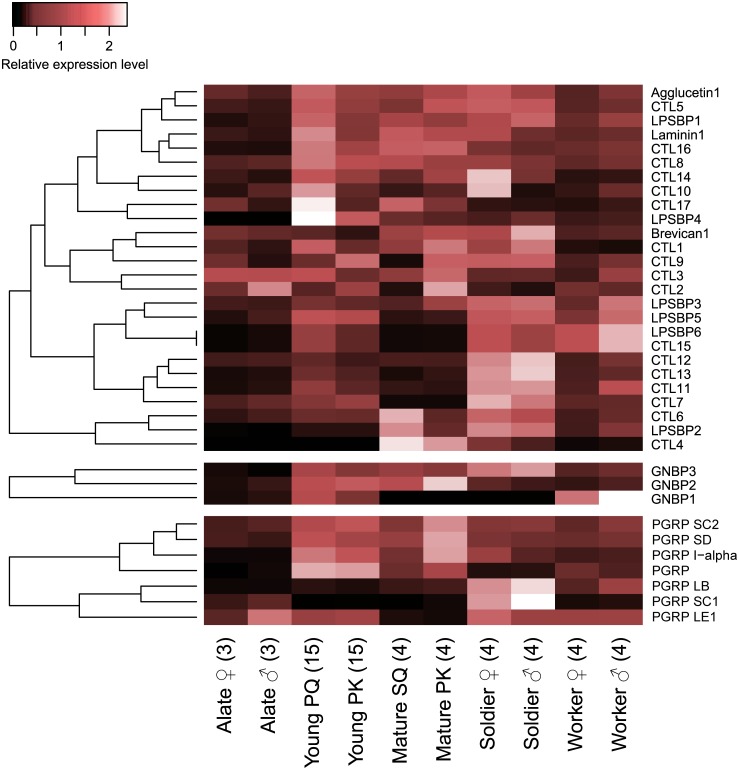
Differential expressions of CTLDs, GNBPs and PGRPs among castes.These heatmaps indicate the differential expression of 29 genes belonging to the CTLD superfamily, the GNBP family and PGRPs among termite castes (PQ: primary queen, PK: primary king, SQ: secondary queen). Relative expression level indicates the mean normalized count per million (CPM), ranging from black (scaled expression of 0) to white (scaled expression of 2.5). The tree at the left corresponds to hierarchical clustering of cluster-averaged expression. Numbers in parentheses after caste names refer to the numbers of biological replicates. Ten individuals were pooled for each sex of worker and soldier to obtain sufficient amounts of RNA, while single individuals were used for RNA extraction in the other castes. CTL: C-type lectin-like domain protein, LPSBP: lipopolysaccharide-binding protein, GNBP: Gram-negative binding protein, PGRP: peptidoglycan recognition protein.